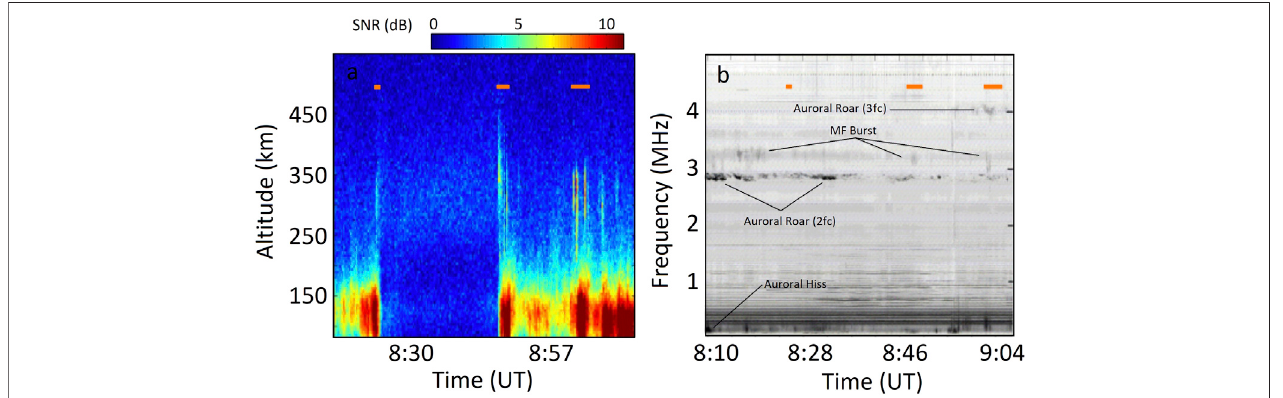
FIGURE 10 | Adapted from Akbari et al. (2013): Correlation of Langmuir turbulence echoes and MF Burst. (A) Range – Time – Intensity plot of received power in the ion line channel from the Poker Flat incoherent scatter radar, showing the occurrence of coherent echoes in three intervals on April 5, 2012. (B) Spectrogram of natural electromagnetic emissions recorded at Toolik Lake, AK. For aiding the comparison, the locations of the LT echoes are marked on the two panels with orange bars.